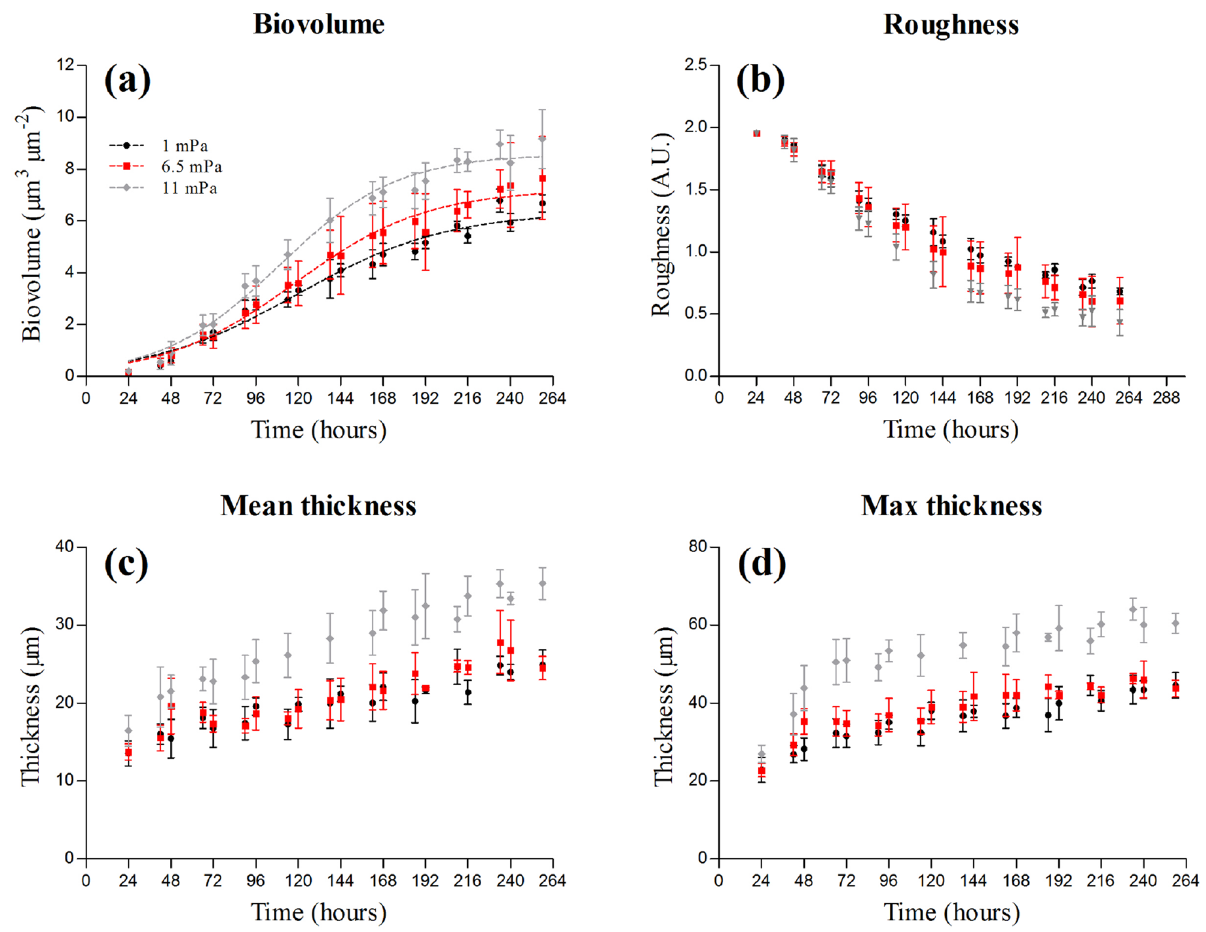
Figure 1. Structural parameters of C. vulgaris biofilms grown in flow-cells at three hydrodynamic shears (1.0, 6.5 and 11.0 mPa). Biovolume ( a ), roughness ( b ), mean ( c ) and max thickness ( d ) are reported as function of time. The biovolume curves were fitted using the logistic function (dashed lines). The results are reported as the mean and standard deviation of at least three independent biological replicates. Error bars represent the standard deviation (n ≥